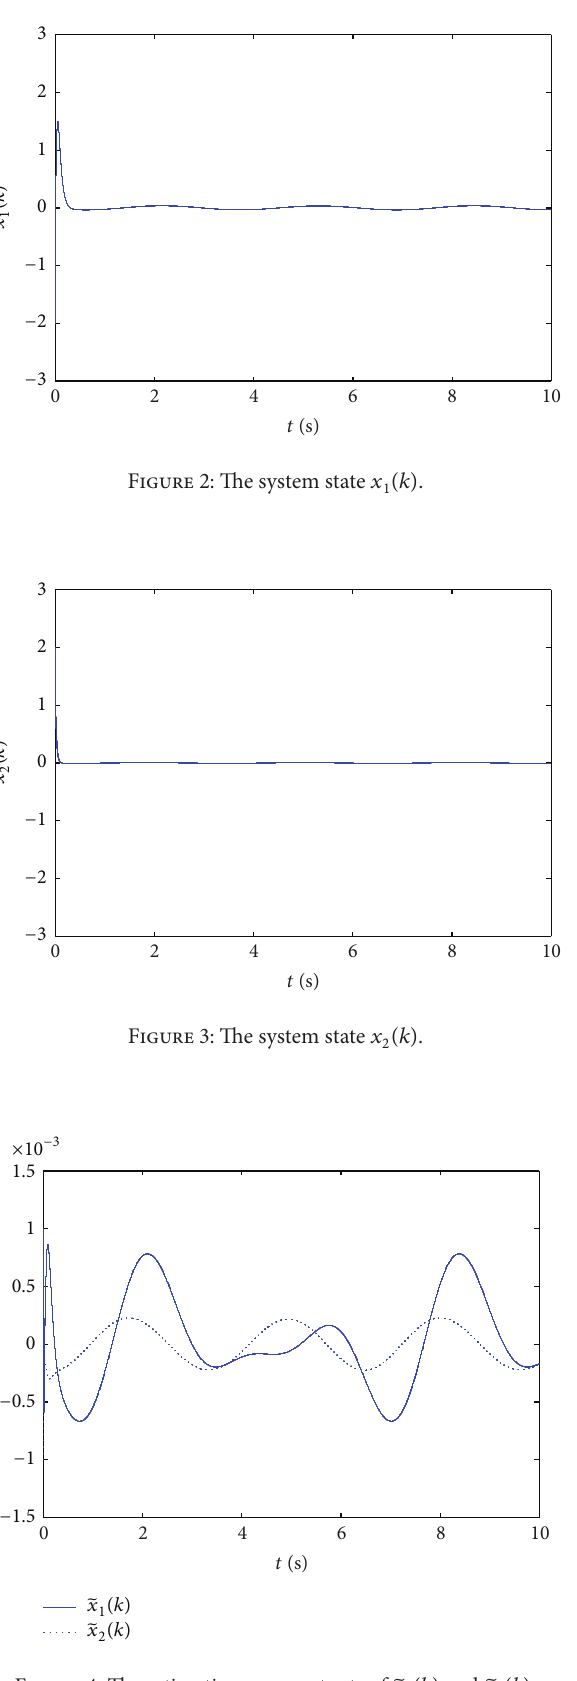
Figure 7: The control inputs 𝑢 1 (𝑘) and 𝑢 2 (𝑘)